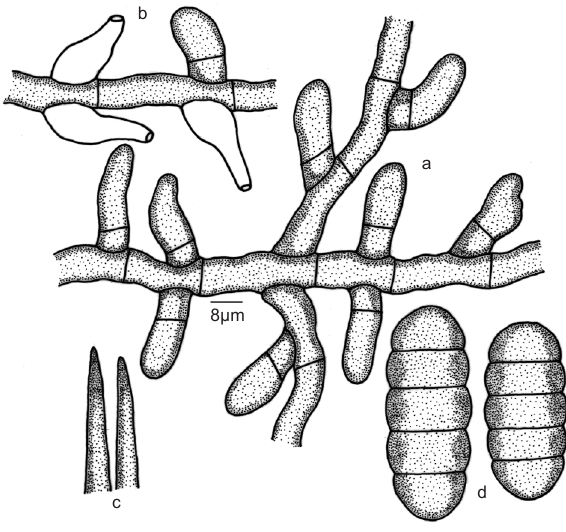
Figure 3. Meliola ebeni sp. nov. a - Appressorium; b - Phialide; c - Apical portion of the mycelial setae; d -